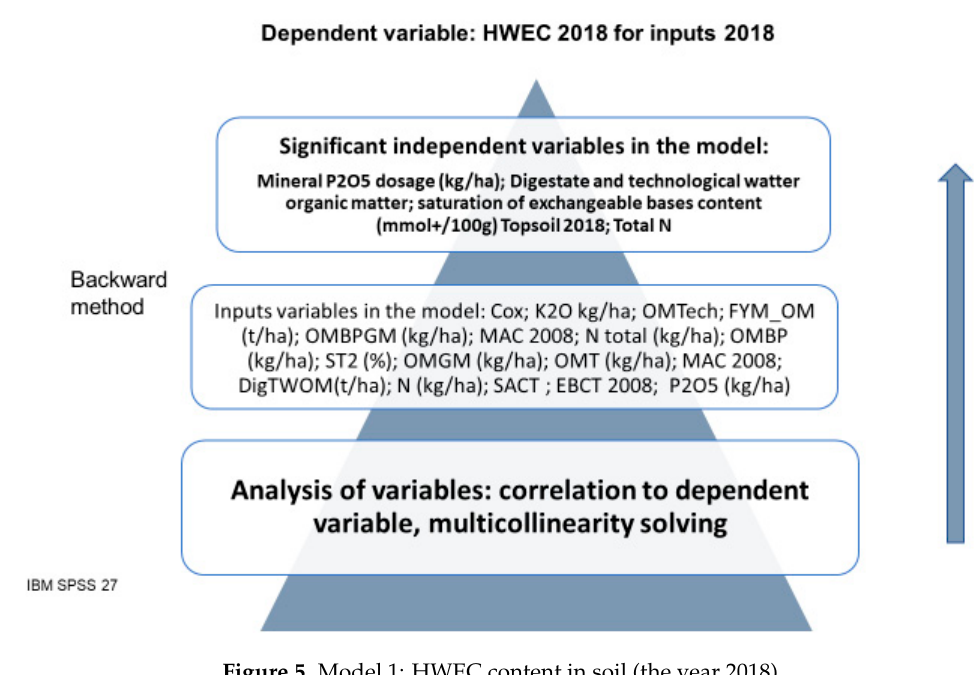
Figure 5. Model 1: HWEC content in soil (the year 2018).